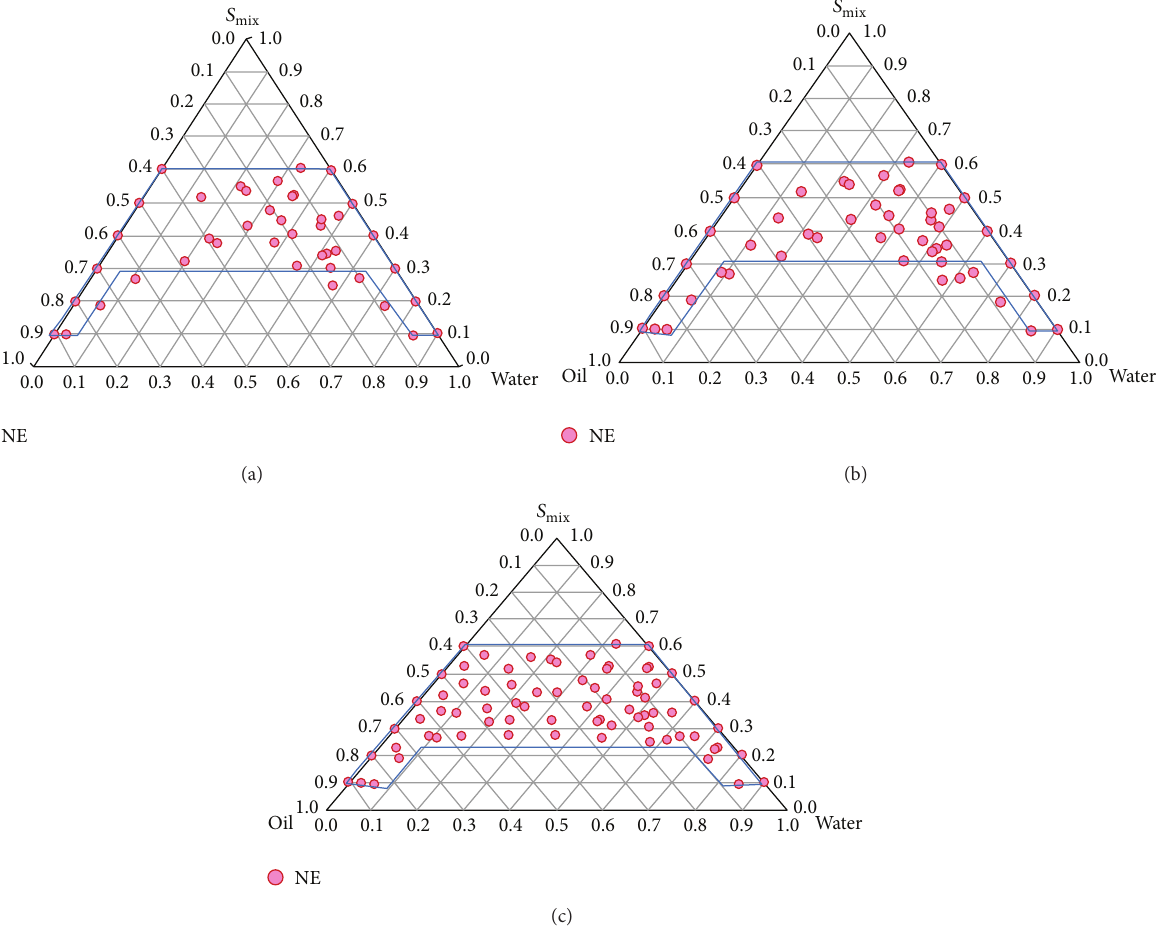
Figure 2: Schematic presentation of nanoemulsion region within the experimental domain (red dots) in the ternary phase diagram (values have been reduced to 1/100th in the plot): (a) 𝑆